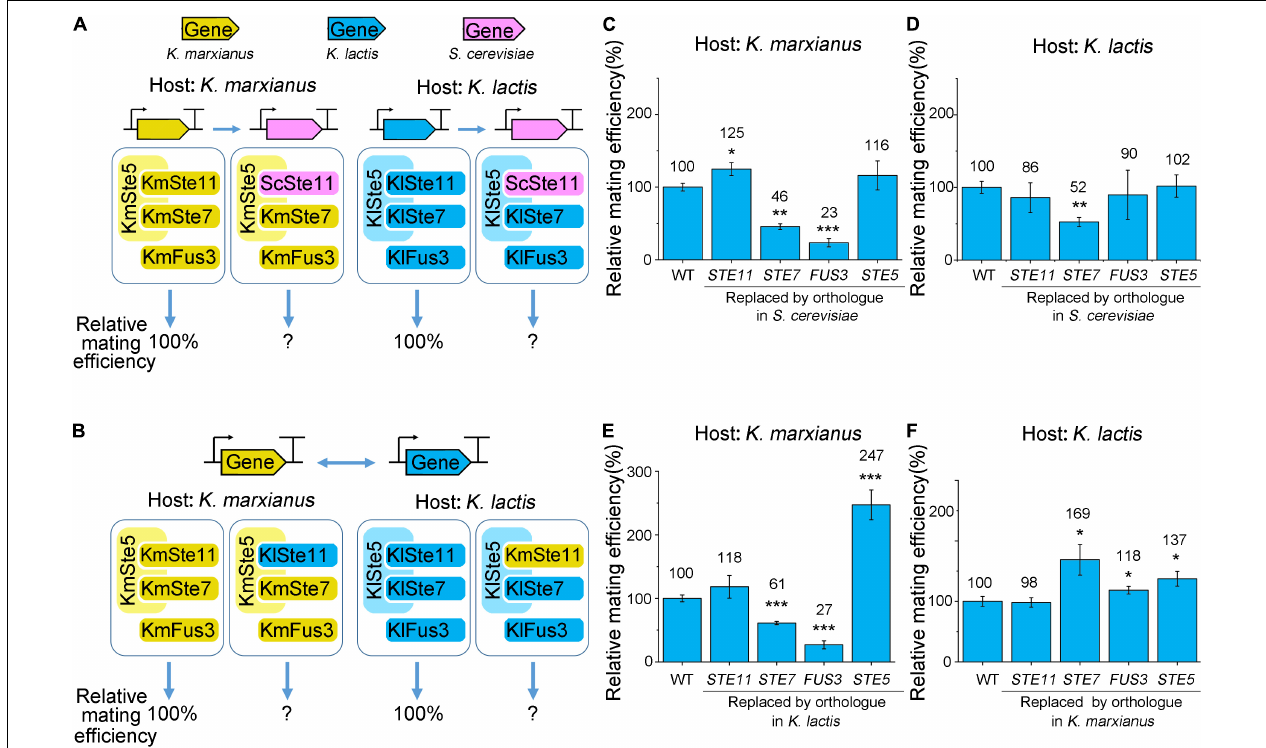
FIGURE 3 | Functional replaceability of orthologs of Ste5 and associated kinases in K. marxianus and K. lactis . (A,B) Schematic representation of the interspecies complementation. Gene encoding Ste5 or kinase in K. marxianus or K. lactis was replaced by its orthologs in S. cerevisiae at the natural locus (A) or was swapped between K. lactis and K. marxianus (B) . Here and elsewhere in this paper, a prefix of “Km” stands for K. marxianus and “Kl” stands for K. lactis . (C–F) Relative mating efficiencies of K. marxianus and K. lactis carrying ortholog of Ste5, Ste7, Ste11 or Fus3. K. marxianus strain LHP508 (WT), LHP699 ∼ LHP702 were subjected to the quantitative mating assay in (C) . K. lactis strain LHP570 (WT), LHP708 ∼ LHP711 were subjected to the assay in (D) . LHP508, LHP562, LHP564 ∼ LHP566 were subjected to the assay in (E) . LHP570, LHP572, LHP705 ∼ LHP707 were subjected to the assay in (F) . The relative mating efficiency of the wild-type strain was designated as 100%. The value represented mean ± SD from three biological repeats. p -values were obtained using two-tailed two-sample t -tests. (* p < 0.05, ** p < 0.01, *** p <